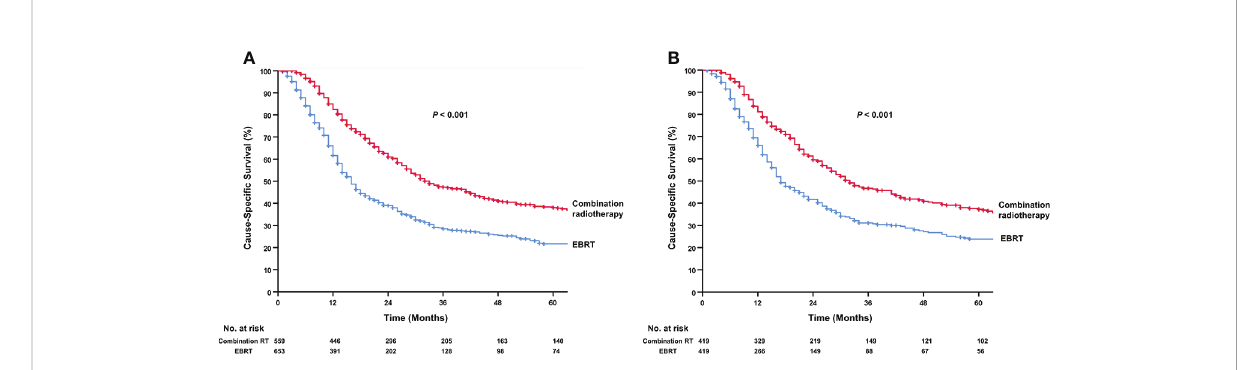
FIGURE 5 Kaplan-Meier curves for cause-speci fi c survival in patients of DLN+ group treated by radiotherapy. (A) combination RT vs. EBRT. (B) combination RT vs. EBRT after propensity-score matched. DLN+, positive distant lymph nodes; EBRT, external beam radiotherapy; RT,